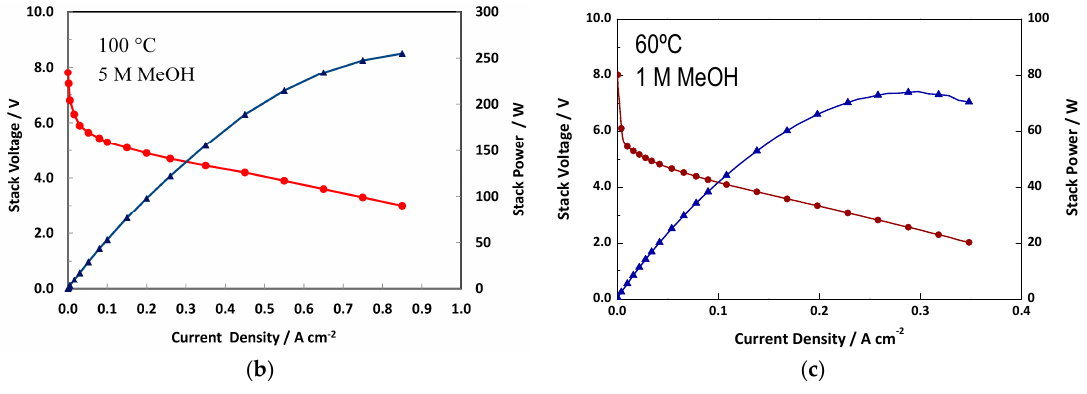
Figure 2. ( a ) DURAMET Project DMFC stack picture; ( b ) 10-cell stack polarization and power curves at 100 °C with 5 M methanol; and ( c ) 10-cell stack polarization and power curves at 60 °C with 1 M methanol concentration.